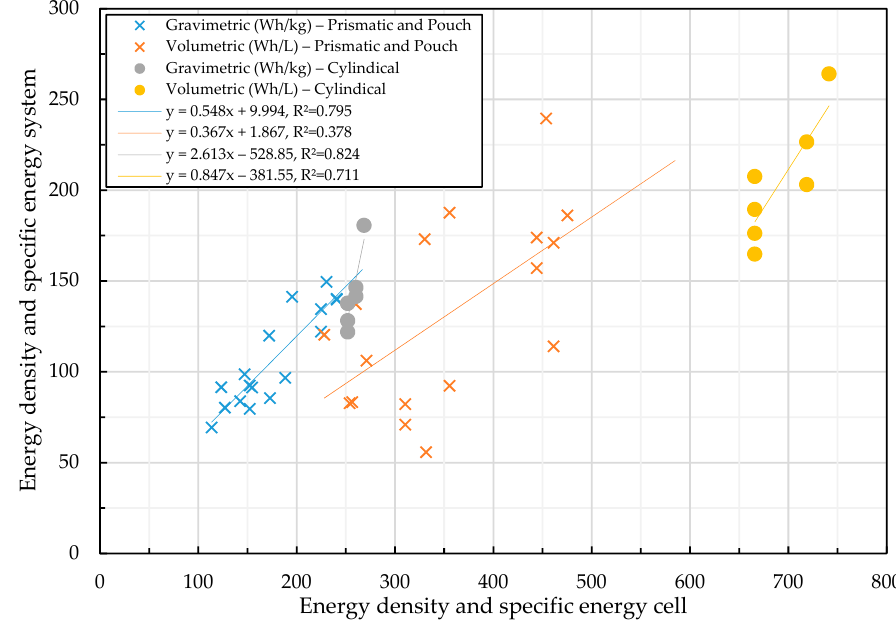
Figure 7. Scaling trend of energy density and specific energy on cell level vs. system level.